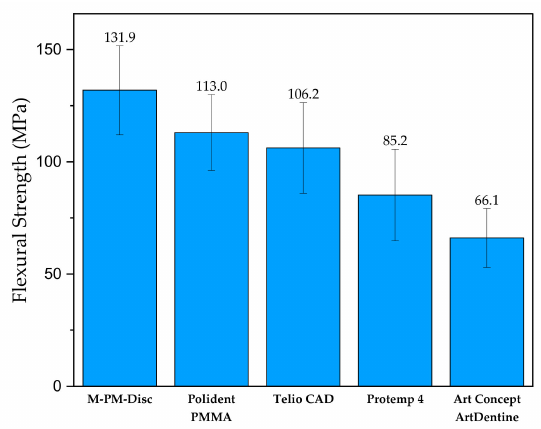
Figure 5. Flexural strength of different commercial interim PMMA-based resins. Adapted from ref.